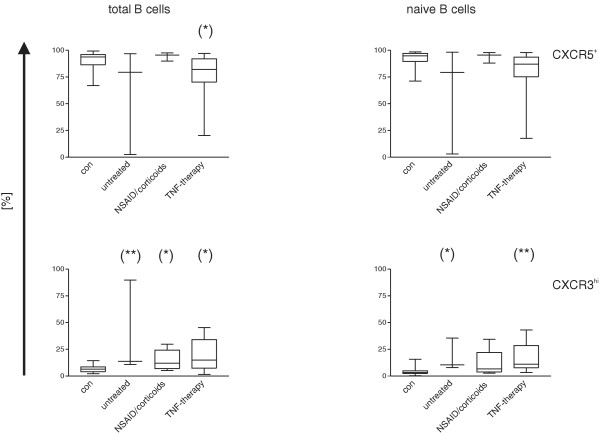
Effect of treatment on CXCR3 and CXCR5 expression. Data are shown for healthy individuals, untreated patients with rheumatoid arthritis and patients treated with corticoid and/or non-steroidal anti-inflammatory drugs or treatment with anti-tumor necrosis factor-α therapy. The percentage of CXCR3hi and CXCR5+ B cells is shown for total B cells and the subpopulation of naive B cells. Box plots show the median values, 25th and 75th quartile and the range of values. Significant differences from controls are shown (*P < 0.05, **P < 0.005). Con, control; RA, rheumatoid arthritis; SLE, systemic lupus erythematosus.